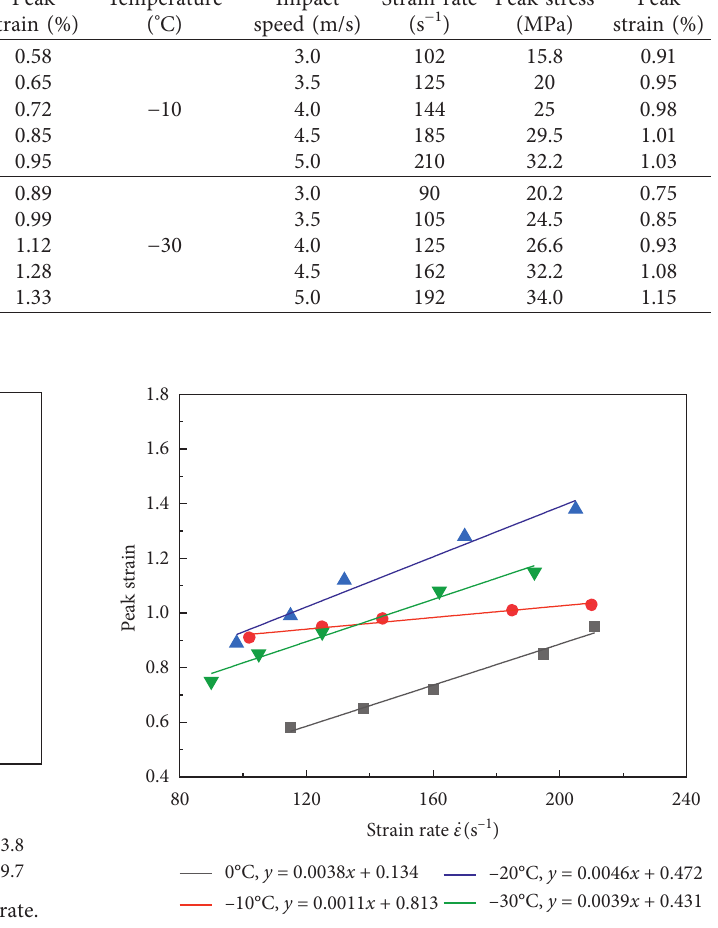
Figure 4: Relationship between peak strain and strain